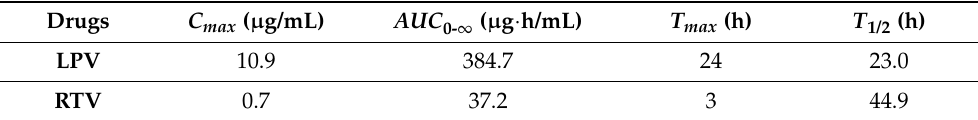
Figure 4. Release of LPV and RTV from the ISNP-based LPV-RTV injection in a simulated physiologi- cal condition. The study was performed in PBS (pH 7.4) at 37 ◦ C for 15 days. Released LPV and RTV were measured by HPLC. Data are presented as the mean ± SD ( n = 4). Table 2. Pharmacokinetic parameters of LPV and RTV following subcutaneous injection of the ISNP-based LPV/RTV injection at a dose of 100 mg/kg LPV in